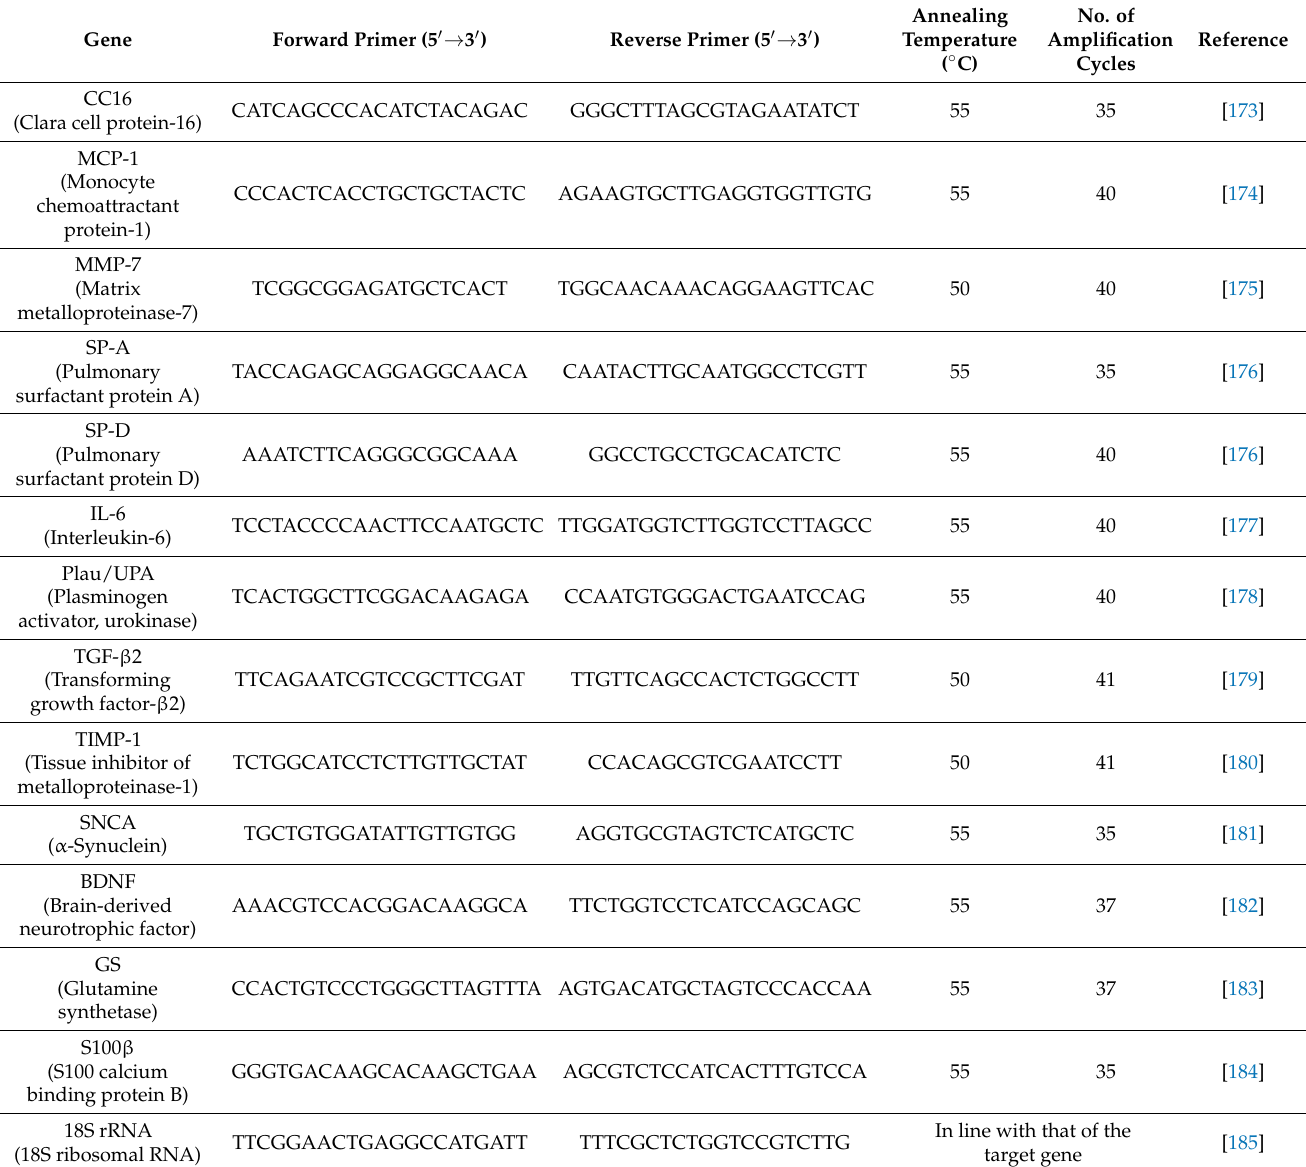
RNase-free water, thus totaling a final volume of 25 µ L. Primer sequences are specified in Table 1. RNA template controls (RTC) and non-template controls (NTC) were included in each run. Table 1. Primer nucleotide sequences and specifications of the amplification programs used for quantitative Real-Time PCR (qRT-PCR) gene expression analysis of lung, cardiac, and neurotoxicity biomarker genes. Gene Forward Primer (5 (cid:48) → 3 (cid:48) ) Reverse Primer (5 (cid:48) → 3 (cid:48)